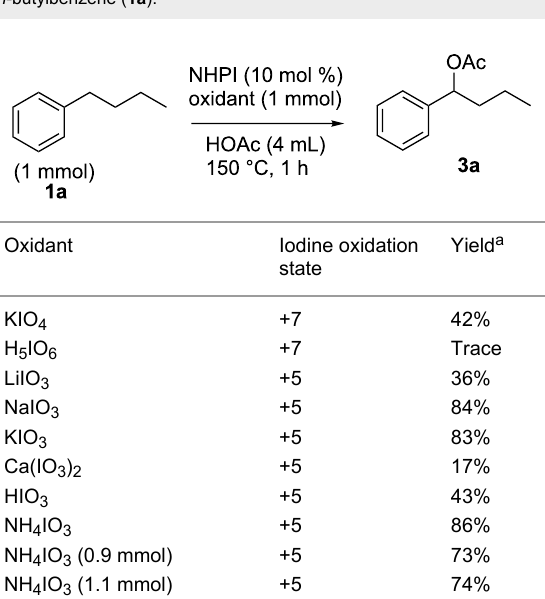
Oxidant Iodine oxidation